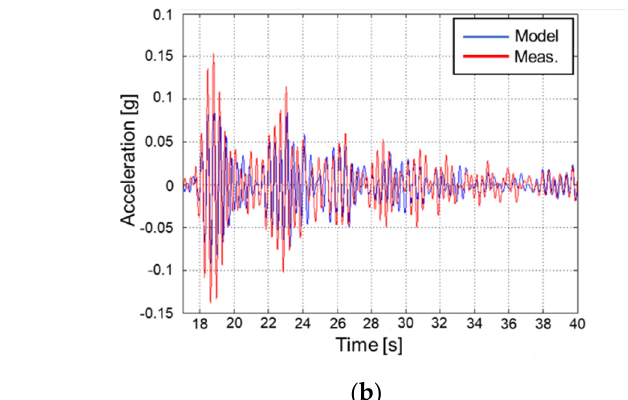
( b ) Figure 8. Median average relative errors for all the events analyzed. ( a ) Models without vertical springs at the base; ( b ) models with vertical springs at the base. The highest relative error for the maximum acceleration was given by the models that included cracking of the vertical elements (models 16 to 21), but there was no defined trend on the relative error for maximum accelerations among models. This parameter, across accelerometers and models, was relatively high, exceeding by 10% in almost every analysis. In Figure 9, the median relative errors on the maximum acceleration for all the models and sensors analyzed are depicted. In this case, it can be observed that the models that considered vertical springs at the base of the structure usually have greater differ- ences with the measured data. From the models without vertical springs at the base, those with a better fit with the measured data are models 2, 4, 5, 12 and 13. All of those models